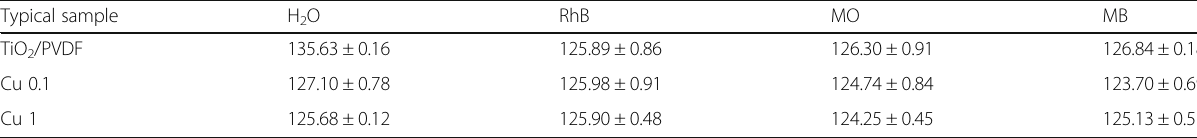
Table 3 The static contact angle of TiO 2 /PVDF fibers, Cu 0.1, and Cu1 Typical sample